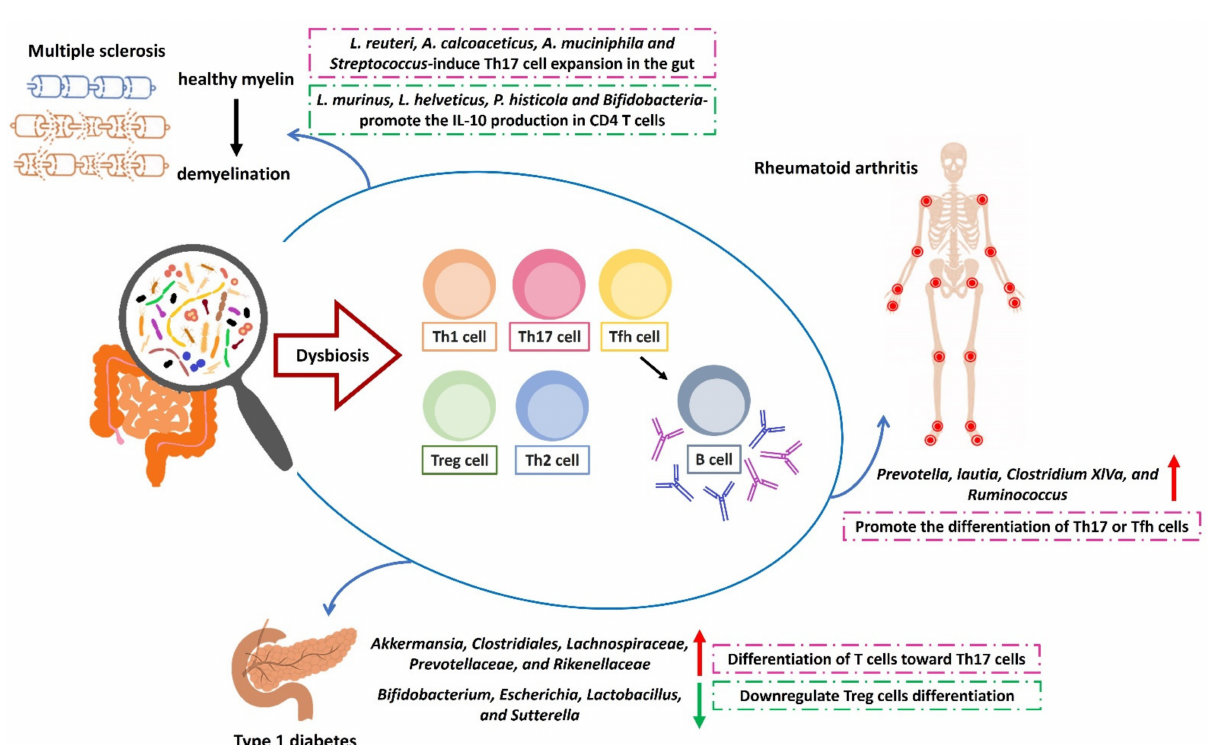
Figure 1. Microbiota modulates the differentiation T helper cells in the pathogenic conditions of autoimmune diseases. The critical interaction between gut microbiota and immune cells in autoimmune diseases. The outcome of gut microbiota- mediated inflammation by the different subsets of CD4 + cells in the specific tissue. In T1D, the augmented expression of bacteria from Akkermansia , Clostridiales , Lachnospiraceae , Prevotellaceae , and Rikenellaceae in the gut can promote the Th17 cell differentiation, whereas the decrease of Bifidobacterium , Escherichia , Lactobacillus , and Sutterella contribute to the downregulated expression of Treg cells. In MS, the enhanced expressions of L. reuteri , A. calcoaceticus , A. muciniphila , Streptococcus modulate the expansion of intestinal Th17 cells, whereas the upregulation of L. murinus , L. helveticus , P. histicola and Bifidobacteria is able to augment the expression of the anti-inflammatory cytokine IL-10 in Th cells. In RA, bacteria of Prevotella , Lautia , Clostridium XIVa , and Ruminococcus can promote the differentiation of Th17 or Tfh